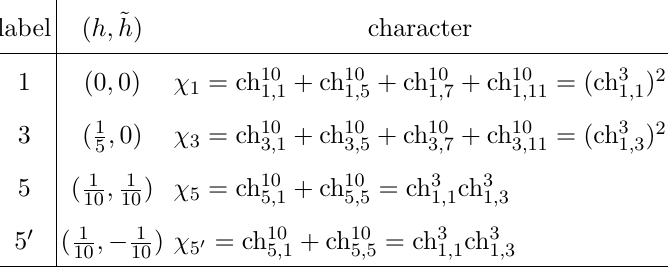
Table 6 . The NS representations of SW (3 = 2) at c = 7 = 5.